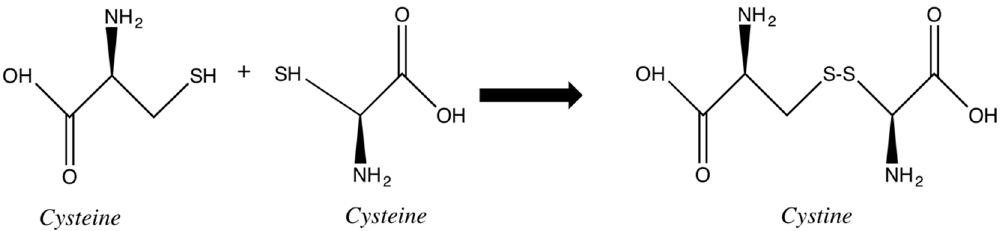
Figure 5. Cystine formation due to disulfide bond between two cysteines.